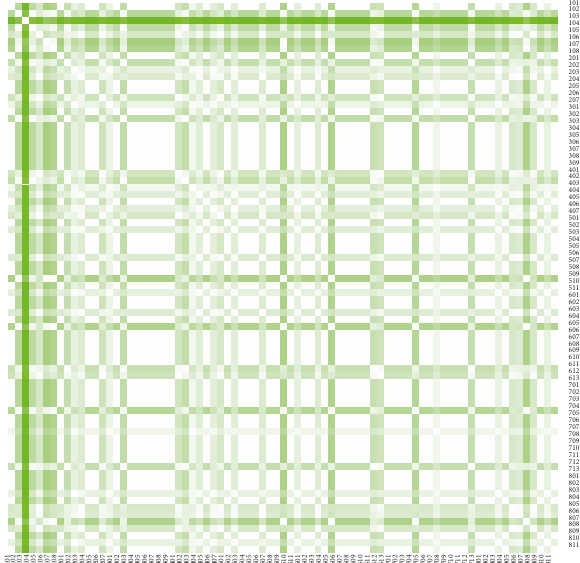
Figure 16: The distance matrix of the similarity of the districts for the male sex in